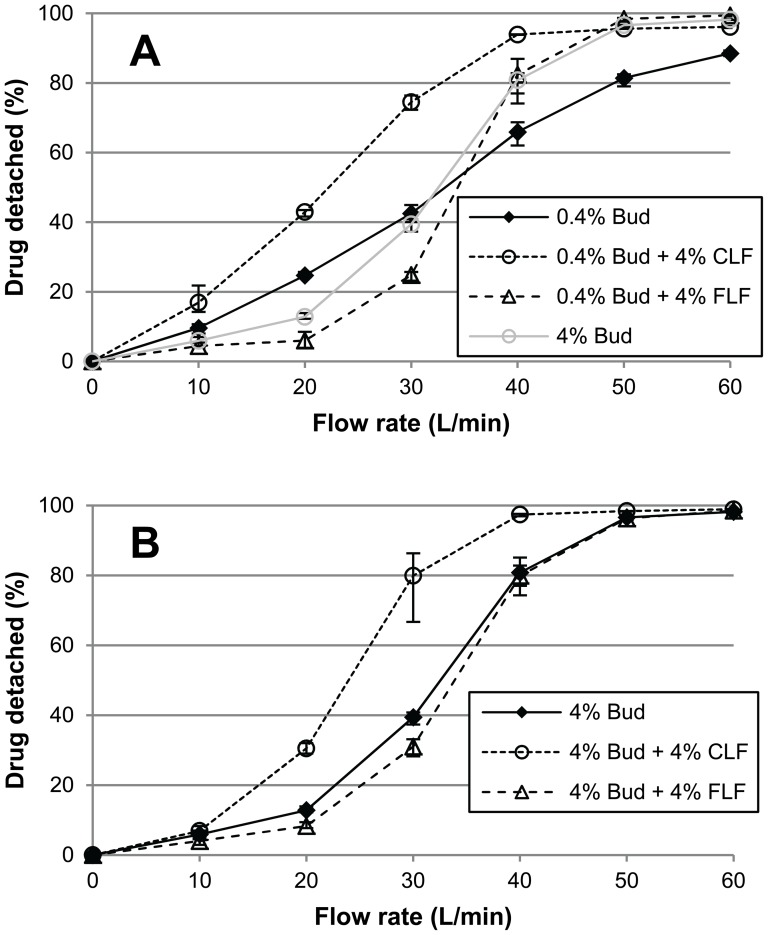
The effects of added lactose fines on drug detachment over a range of flow rates.
A) effects of 4% fine lactose fines (FLF) or 4% coarse lactose fines (CLF) on drug detachment of 0.4% budesonide mixtures and B) for 4% budesonide mixtures. Error bars represent maximum and minimum values measured (n = 5).